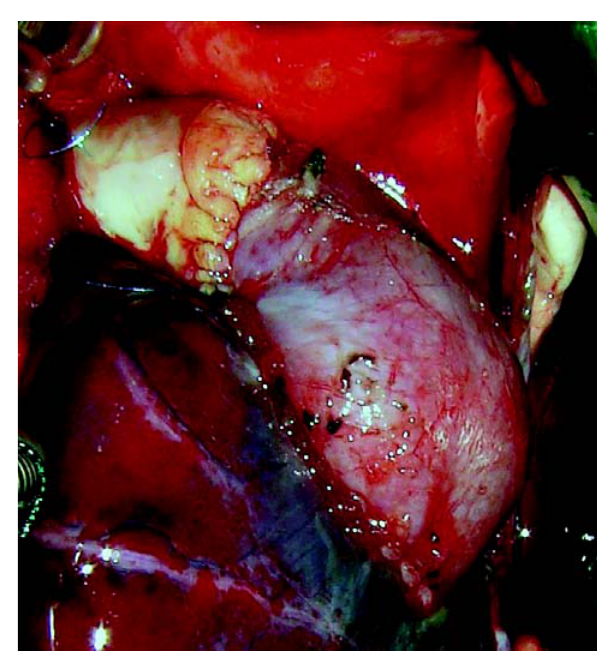
Fig. 2 – Xenoenxerto porcino L-Hydro implantado na via de saída do ventrículo direito e ampliação com pericárdio autólogo